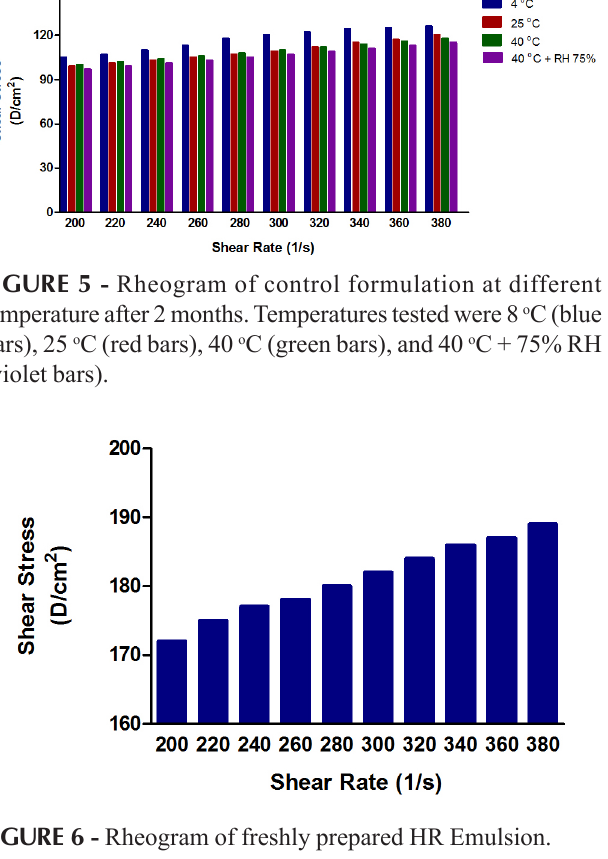
FIGURE 6 - Rheogram of freshly prepared HR